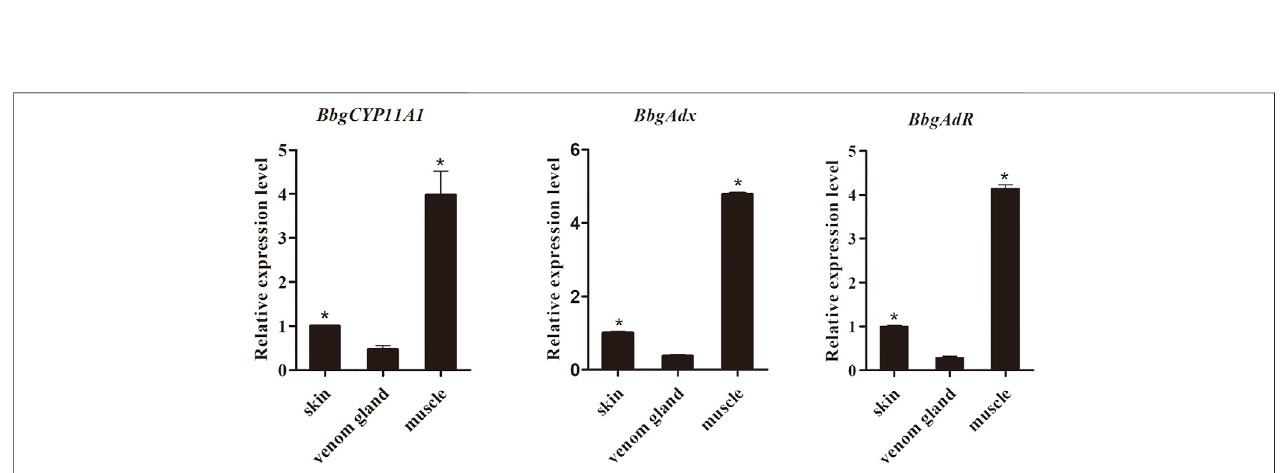
FIGURE 7 | The expression pattern of genes in P450scc system among different tissues of B. bufo gargarizans . (* p < .05).